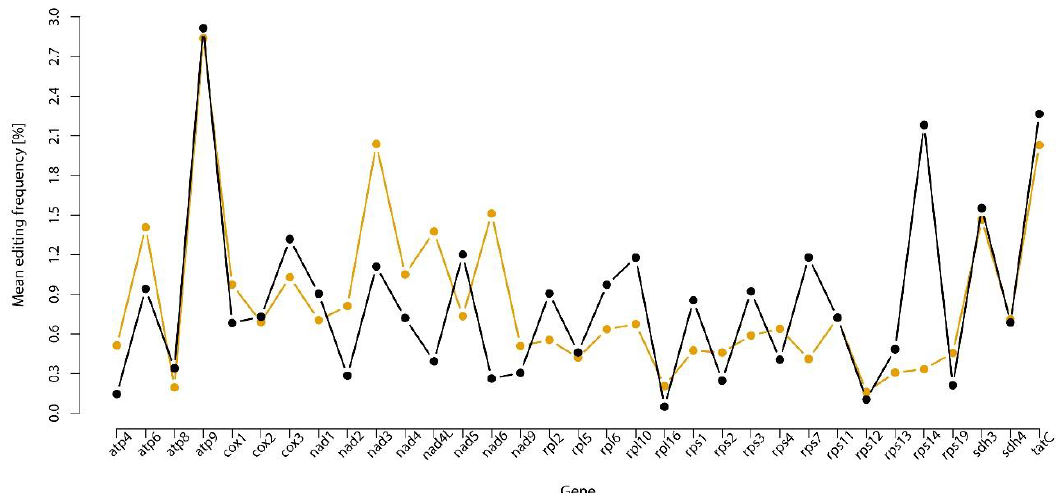
Figure 4. Mean C-to-U RNA editing frequency in genes of mosses and liverworts. The means of C-to-U RNA editing frequency of liverworts (orange line) and mosses (black line) are scaled.